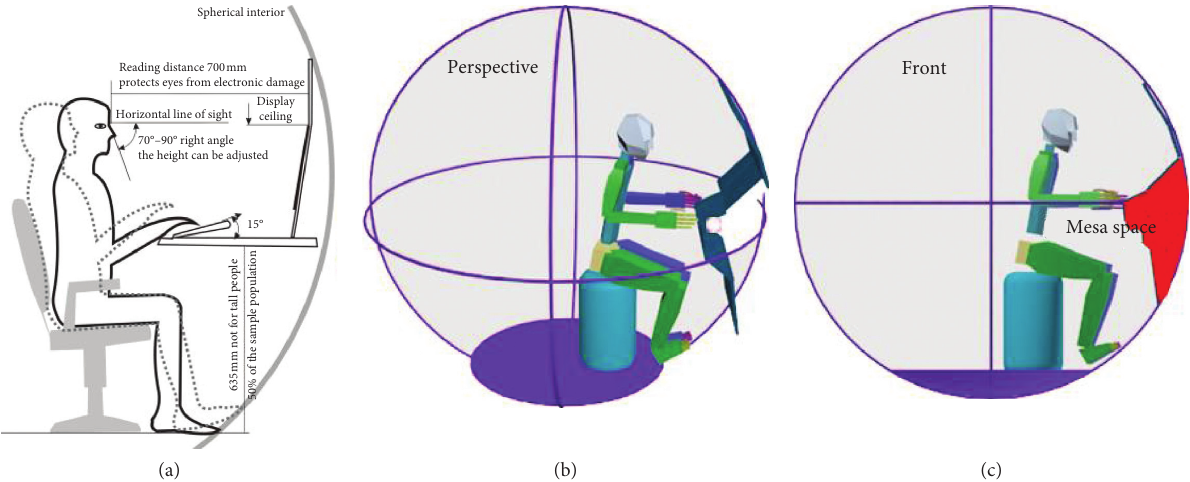
Figure 2: Reconstruction and optimization of the working table and display system of manned submersible